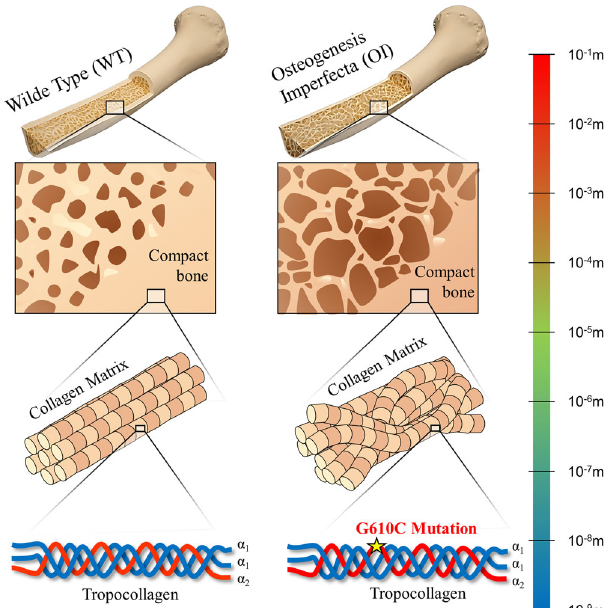
Fig. 1 Hierarchical structure of WT and OI bones. OI is a genetic bone disorder resulting in abnormal structure and material from the tissue to whole bone level, resulting in a decrease in ultimate strength and fracture toughness. The OI used in this study has the G610C mutation at the α 2 chain of a tropocollagen. The OI collagen exhibits a slightly random orientation in its fi ber-level matrix, while the WT collagen reveals a well- aligned structure. This multi-scale abnormality of OI results in a catastrophic effect on bone ’ s mechanical